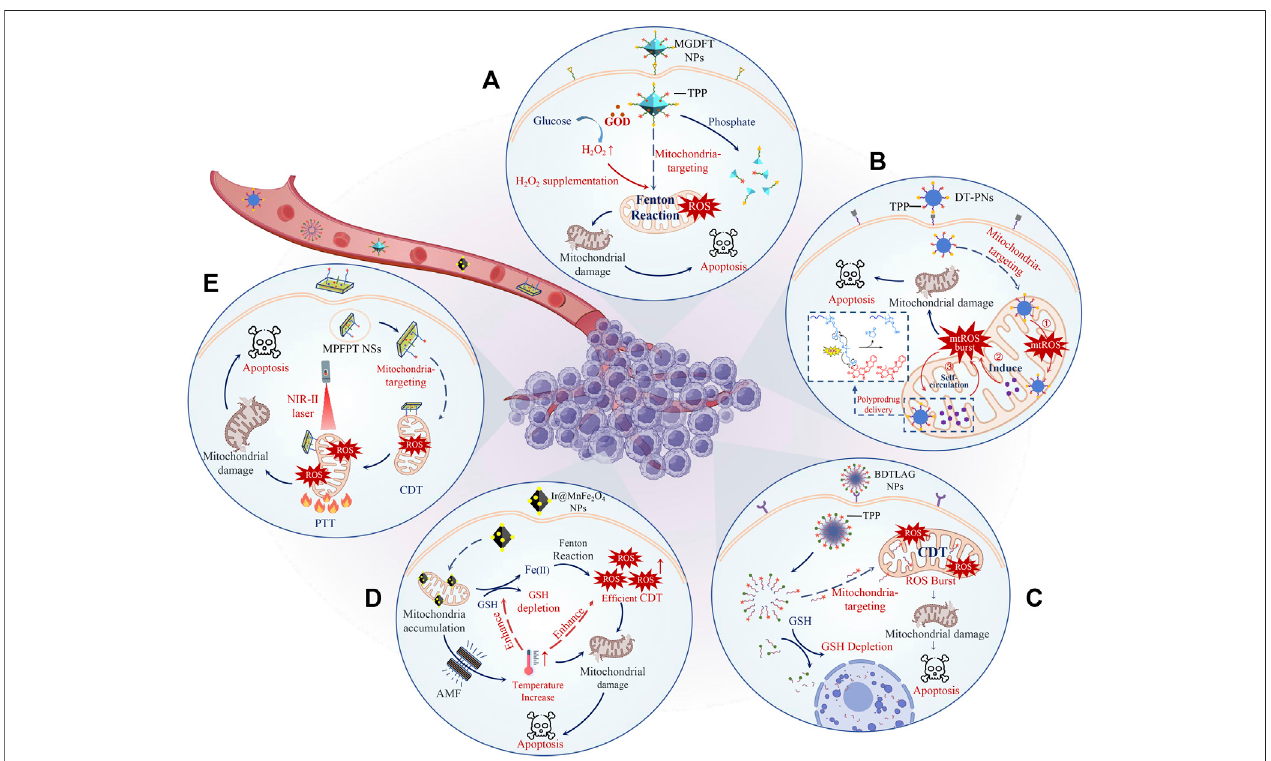
FIGURE 1 | Schematic illustration of representative M-CDT nanodrugs. The therapeutic ef fi cacy of M-CDT nanodrugs is further increased by H 2 O 2 supplementation (A) , non-H 2 O 2 dependent CDT (B) , GSH depletion (C) , and combination with MHT (D) or PTT (E) . To be speci fi c, MGDFT NPs catalyzed the decomposition of glucose into H 2 O 2 and gluconic acid through loaded GOD, signi fi cantly increasing the level of H 2 O 2 (A) . DT-PNs delivered non-H 2 O 2 CDT agents to mitochondriathroughapoly-prodrugdeliverystrategy,triggeringaROSburst insitu andef fi cientlykillingtumorcells (B) .BDTLAGNPsrapidlyconsumedGSHand releasedCDTagentsthroughthereactionofdisul fi debondswithGSH,whichsigni fi cantlyimprovedthetumorkillingeffectofROS (C) .Ir@MnFe 2 O 4 NPsgeneratedhigh temperatures locally in the mitochondria under the AMF, greatly promoting the rate of Fenton reaction and thus producing a high level of ROS to induce mitochondria damage (D) . MPFPT NSs with high photothermal conversion ef fi ciency ef fi ciently accelerated the rate of the Fenton reaction by heating mitochondria, indicating the superiority of PTT-CDT with mitochondria targeting (E)